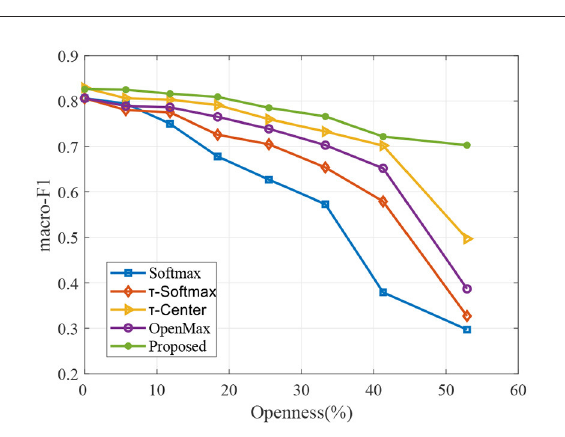
FIGURE5 Macro F1 against varying openness with different methods on the LTM_108